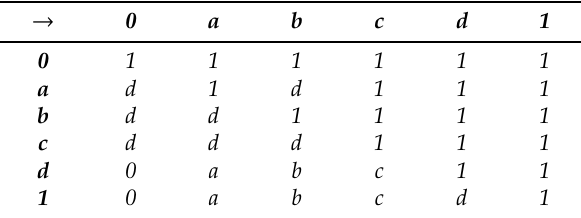
Table 9. The operation → on X .